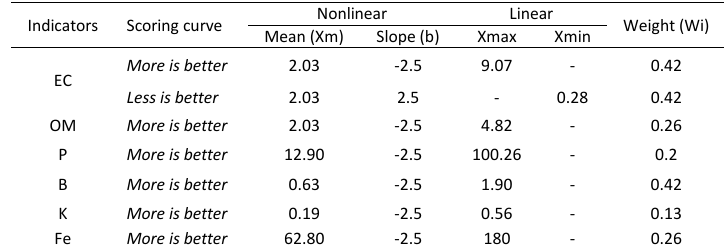
Table 5: Type of scoring curves, the parameters of nonlinear and linear equations, and calculated weights for the indicators in the minimum data